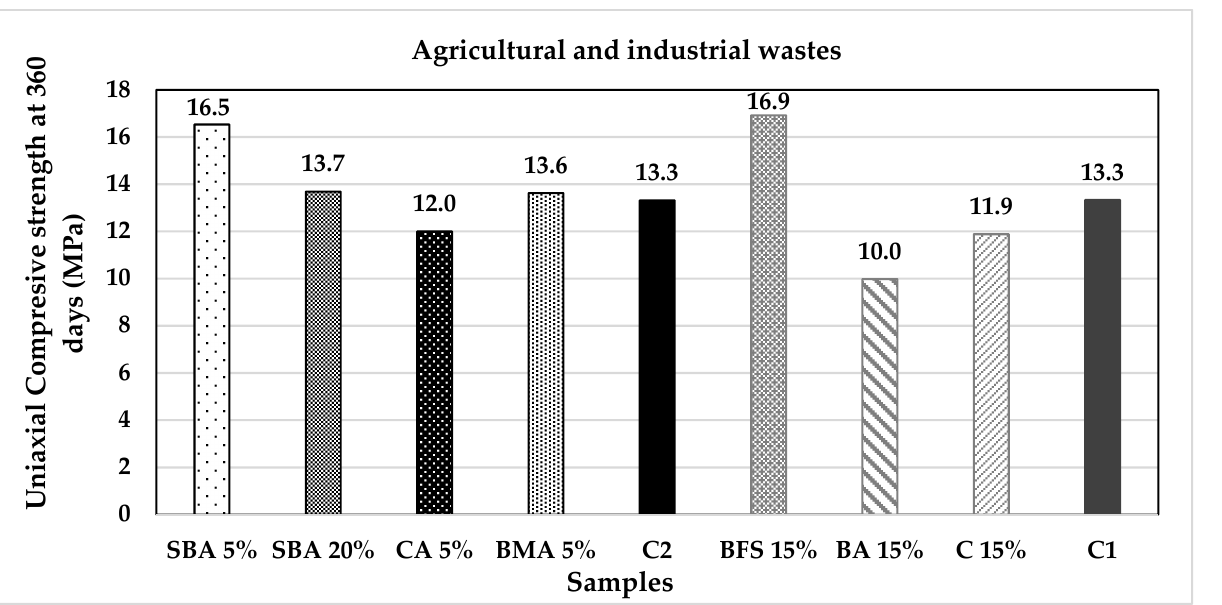
Figure 16. Uniaxial compressive strength of minerals and fibres group of additions. Other substitution material with an unusual behaviour was CA, showing lower me- chanical values than control samples but with a low carbonation velocity, being one of the three materials that achieve in reducing it. CA may act as a filler and not as a pozzolan, allowing to limit the interconnection of the cementitious matrix pores and increase its tor- tuosity without actually densifying the matrix enough to bring more mechanical re- sistance. At last, the results of the electrical resistivity test are shown in Figures 17 and 18. We can observe that all the substitutions proposed present better behaviours than the control samples. Similar than Figures 15 and 16, SBA and MK have higher values of electrical resistivity and uniaxial compressive strength while they favour the faster carbonation. It is known that SBA contain amorphous SiO 2 , which acts as a puzzolana reacting with Ca(OH) 2 produced during the hydration process of cement and water, acting as a retard- ing reaction, resulting into the generation of a saturated zone of calcium silicate hydrate (CSH) gel, selling porous and increasing compression resistance. This CSH gel reduces the amount of calcium hydroxide Ca(OH) 2 and consequently the pH of the cementitious